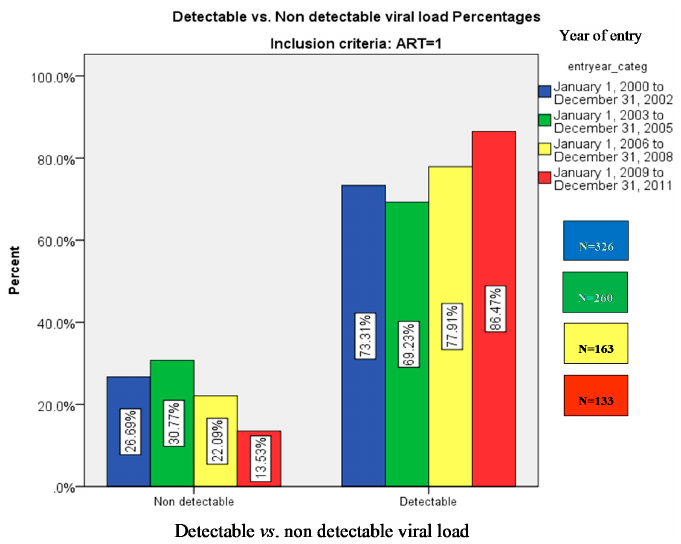
Figure 1. Detectable vs. non-detectable viral load (% patients).